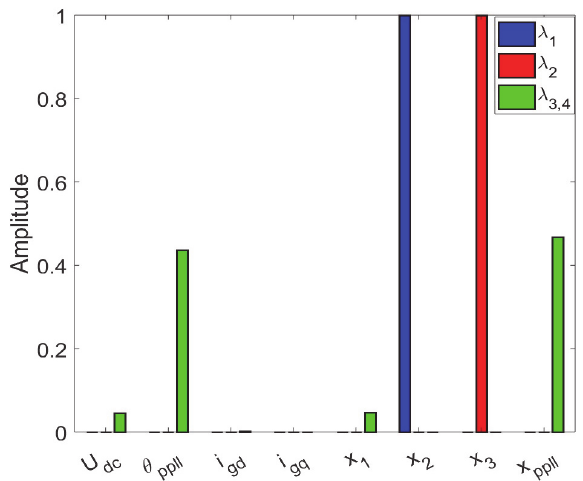
Figure 7. Participation factors of λ 5,6,7,8 with k i 1 = 0.1.